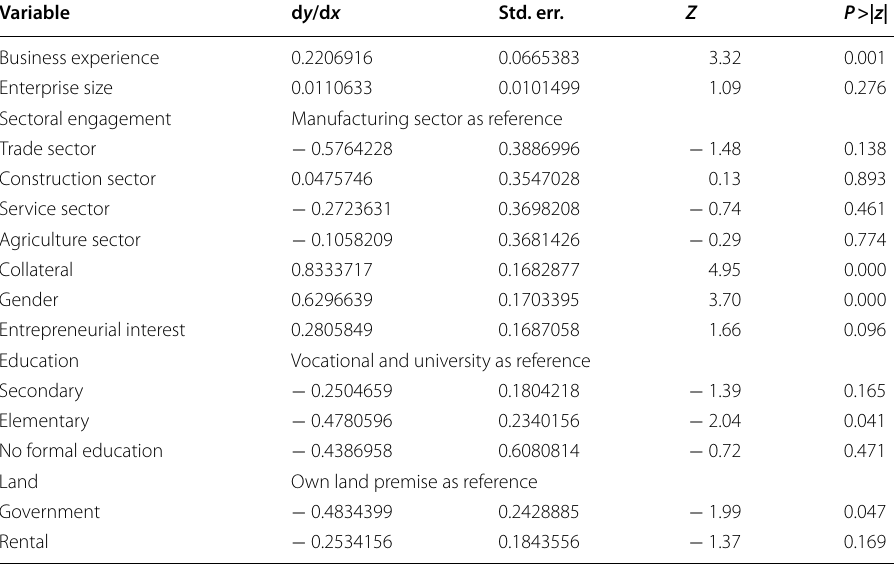
Table 5 Determinants of financing preference (marginal effects from probit estimation) Variable d y /d x Std.